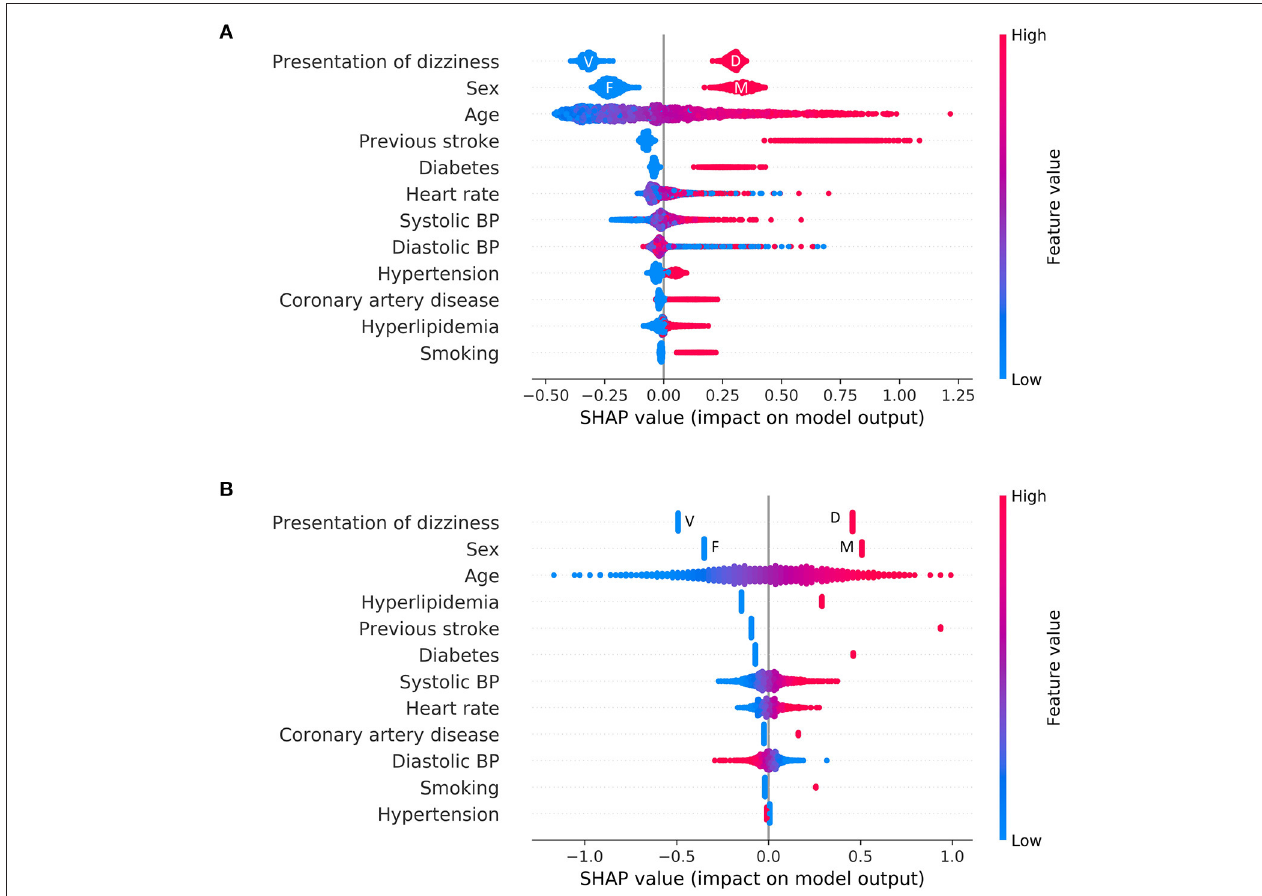
FIGURE 3 | Feature attributions of all features. Summary plot of SHAP values for all features: (A) Logistic regression (B) Catboost. Each point represents the feature attribution on the log-odds scale for one patient in the training set. Continuous variables were colored by feature value. In the case of categorical variables, except for representation of dizziness and sex, the red color denotes a positive (i.e., a patient has the feature), and the blue color denotes negative. F, female; M, male; V, vertigo; D, dizziness.